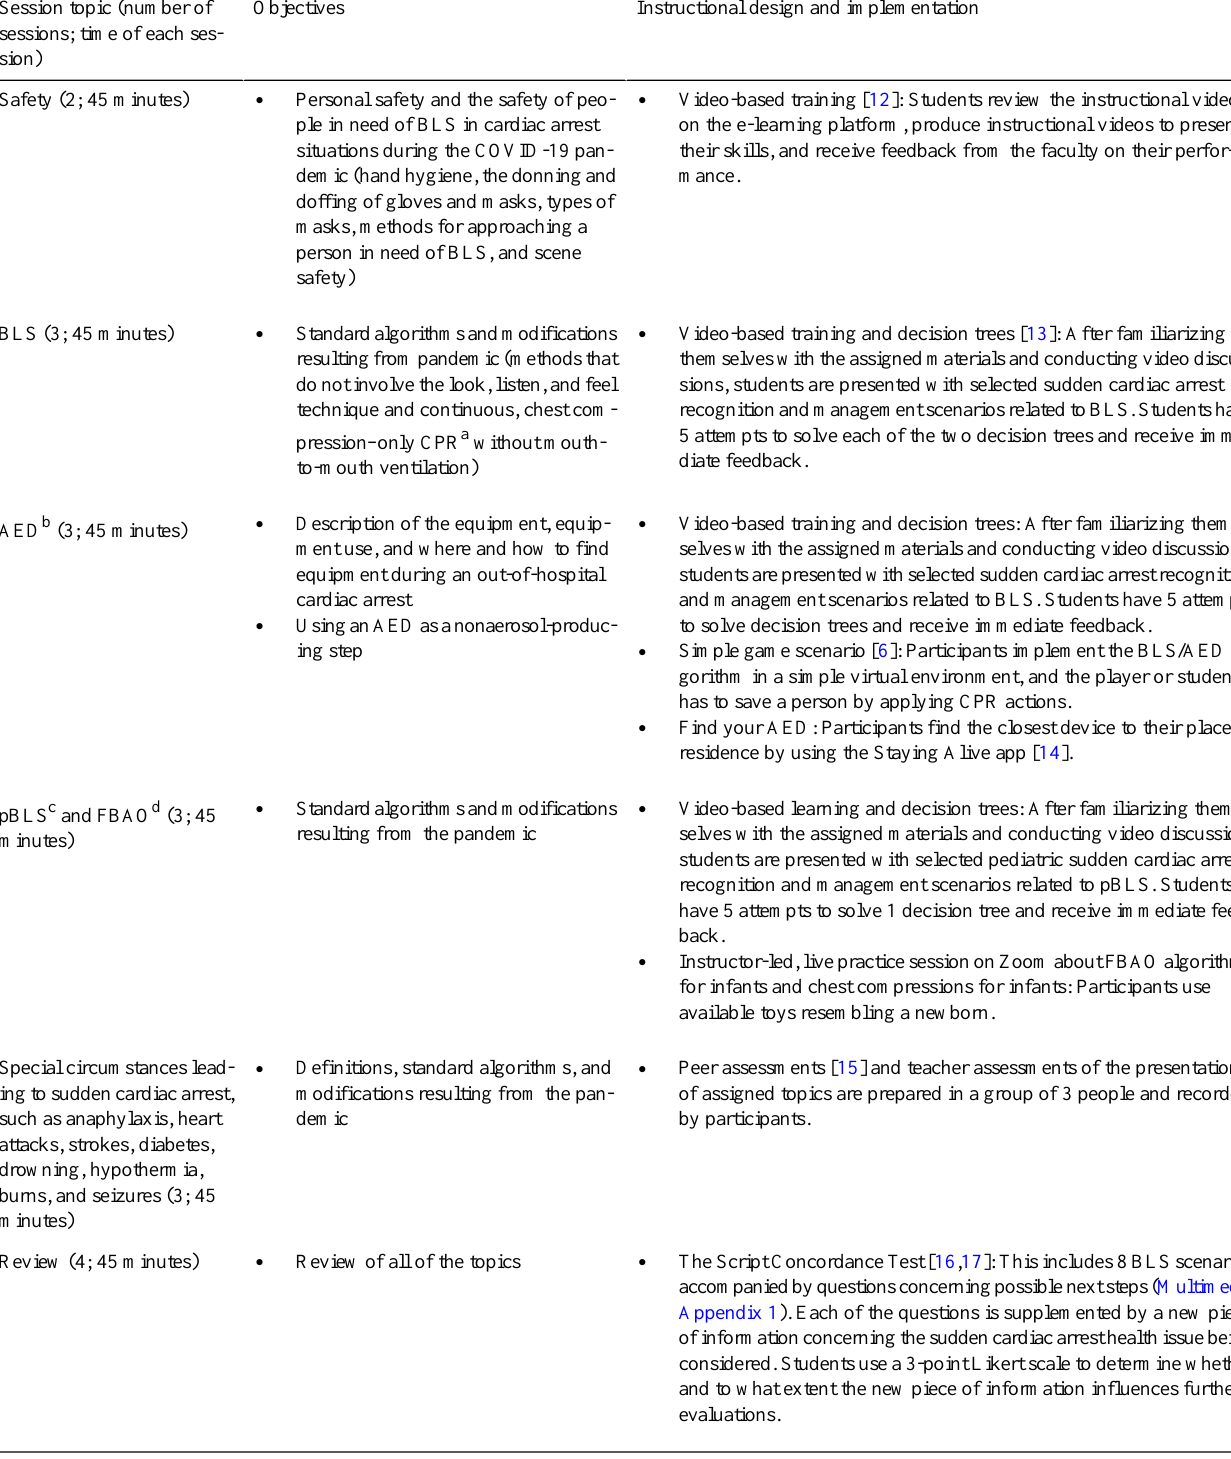
Instructional design and implementationObjectivesSession topic (number